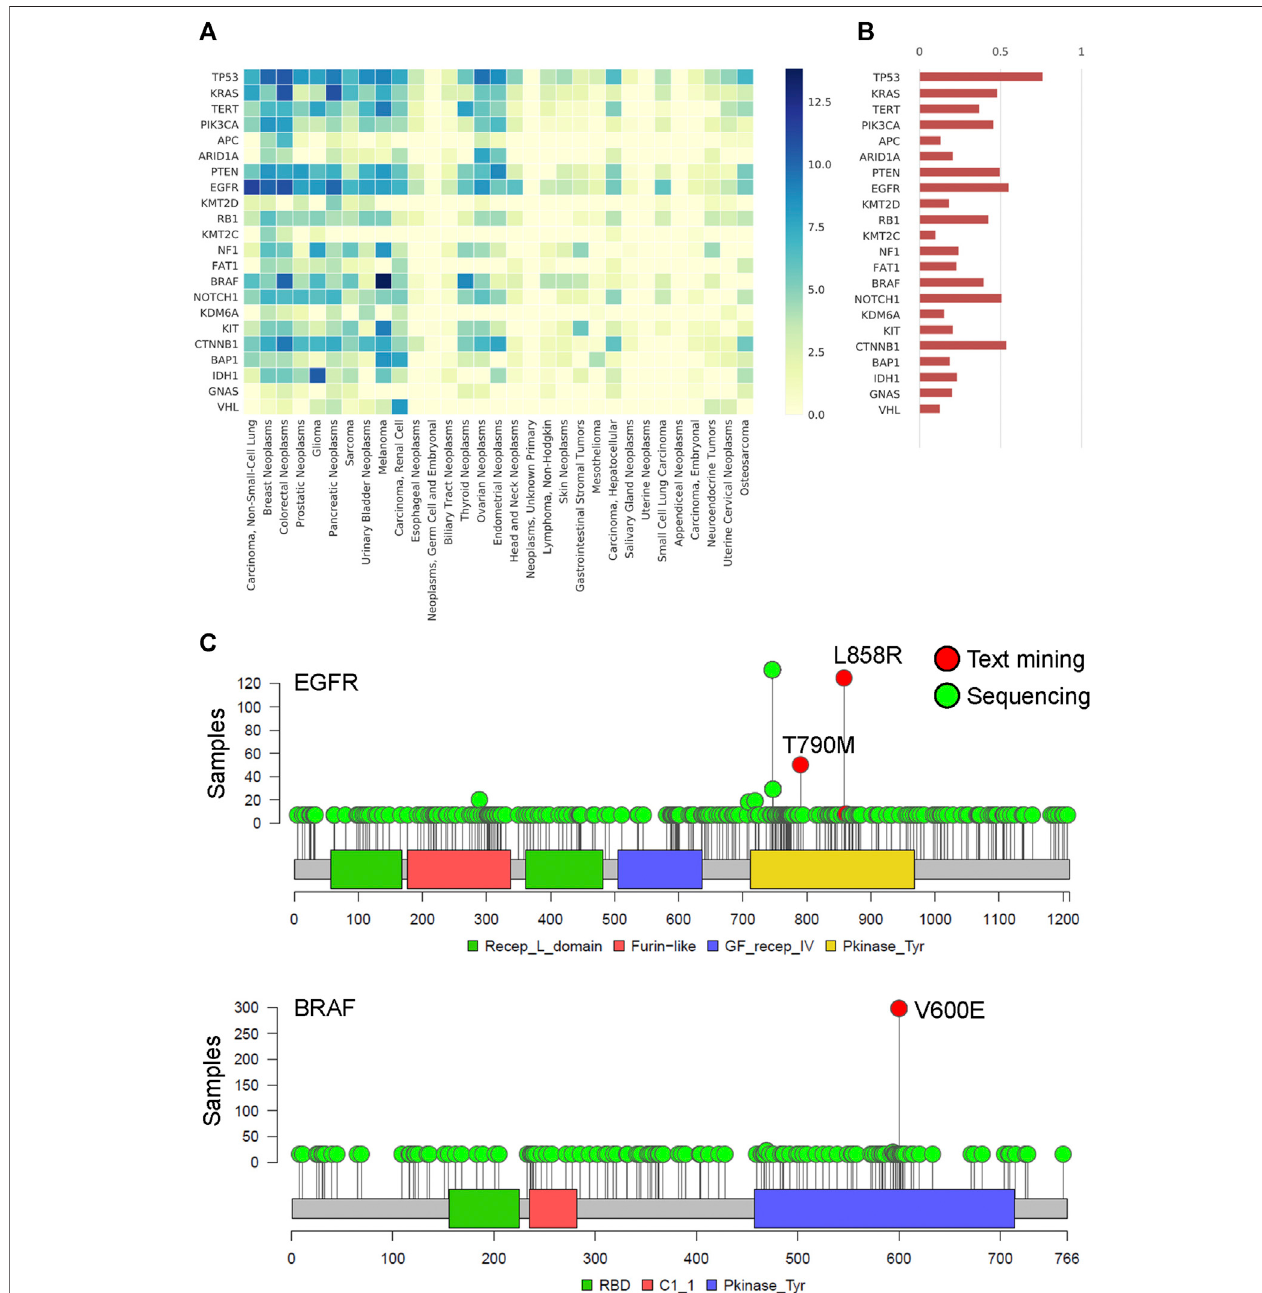
FIGURE 5 | The spectrum and frequency of actionable genetic mutation by literature mining (A) Heatmap of cancer genomics by the TF-IDF matrix. The X-axis represents the 31 common cancer types, and the y-axis represents the recurrent somatic genes. The darker color indicates a higher association between genes and cancer. (B) Thebarplotshowsthegenefrequencywithinallofthecancertypes.ThedataisvalidatedbytheMSK-IMPACTClinicalSequencingCohort,whichistargeted sequencing of10,000clinical cases using the MSK-IMPACT assay. The cosinesimilarityof gene frequency between text mining and astatistical result from clinical sequencingdatais80.8%. (C) Lollipopplotof EGFR and BRAF intheMSK-IMPACTpan-cancercohort.Thecriticalgenemutationtermfeaturesfoundbytextminingare shown and labeled in red. Other gene mutations are labeled in green.